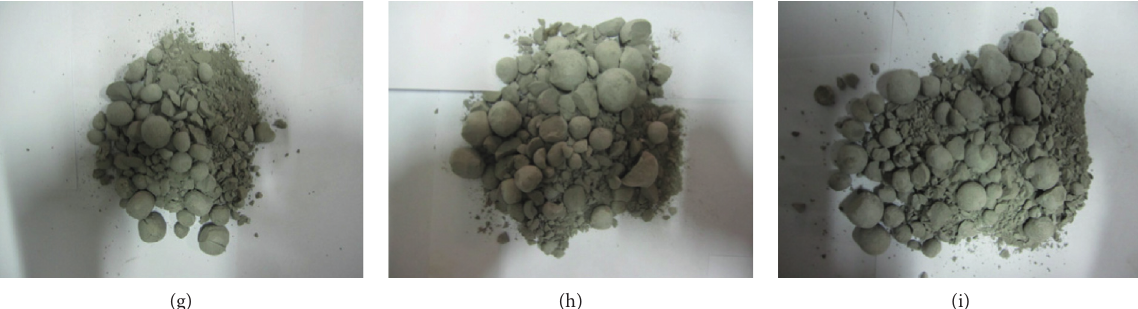
Figure 13: The breakage of cement particles under the loading of 30, 40, and 50 kN: (a–c) in the surface layer; (d–f) in the medium layer; (g–i) in the bottom